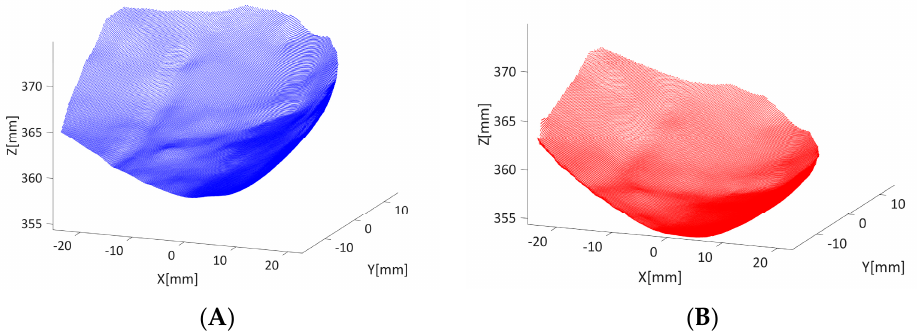
Figure 6. ( A ) 3D reconstruction of the cardiac tissue surface (3DsurfCTS); ( B ) 3D reconstruction of the 3D printed model surface (3Dsurf3DM).